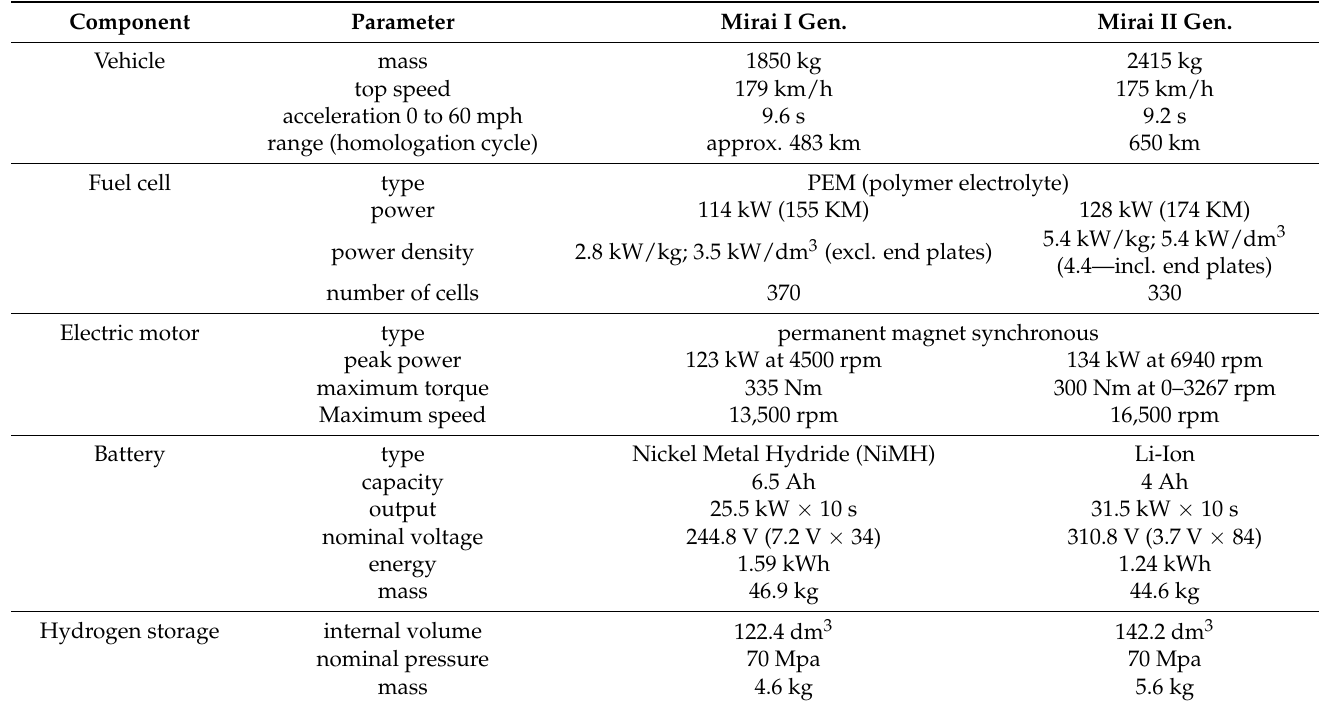
Table 1. Toyota Mirai powertrain system [17,35].